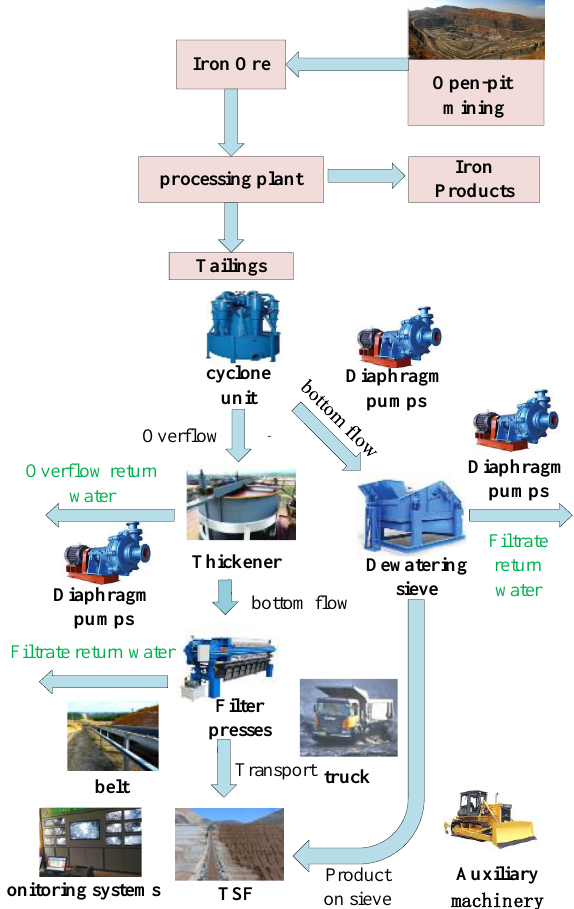
Figure 2. Flowchart of dry stack disposal technology (DSDT).